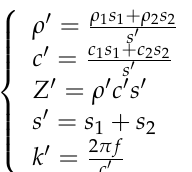
Table 3. Equivalent parameters of each component material of the transducer. Structure of the Transducer Piezoelectric Ceramics PZT-8 3367